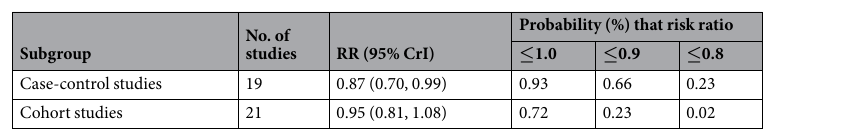
Table 2. Bayesian Meta-Analysis: Association between thiazide use and fracture risk. Abbreviations: RR: risk ratio; CrI: Credible